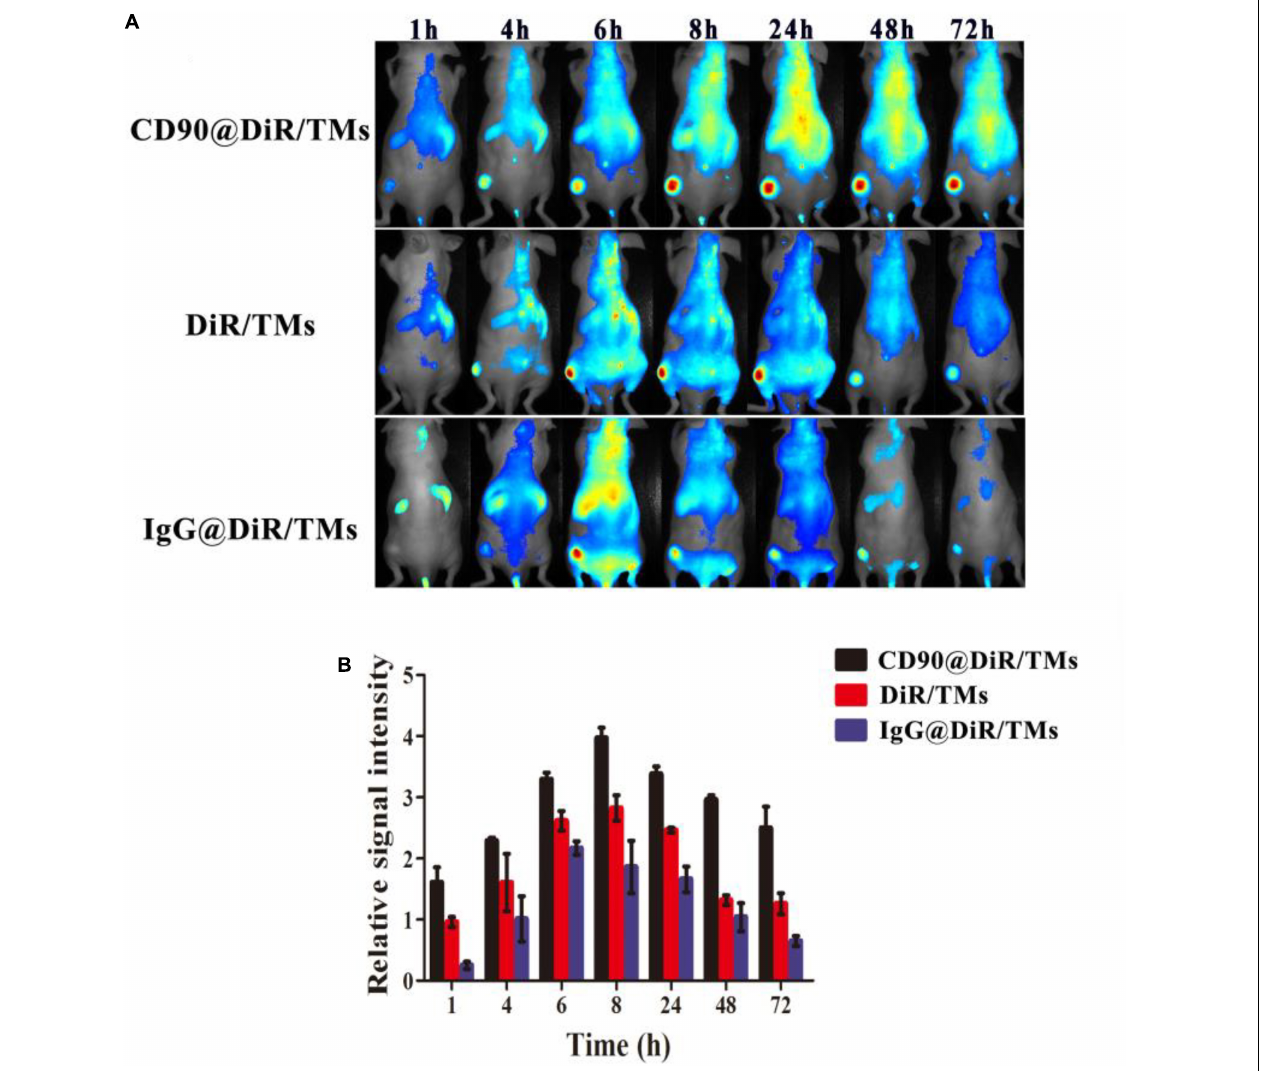
FIGURE 1 | Targeting ability of CD90@DiR/TMs in CD90 + LCSC-bearing mice detected using NIR imaging. (A) NIR images at different time points following the injection of IgG@DiR/TMs, DiR/TMs, and CD90@DiR/TMs. (B) Relative fluorescence intensity of the tumor at different time points following the injection of IgG@DiR/TMs, DiR/TMs, and